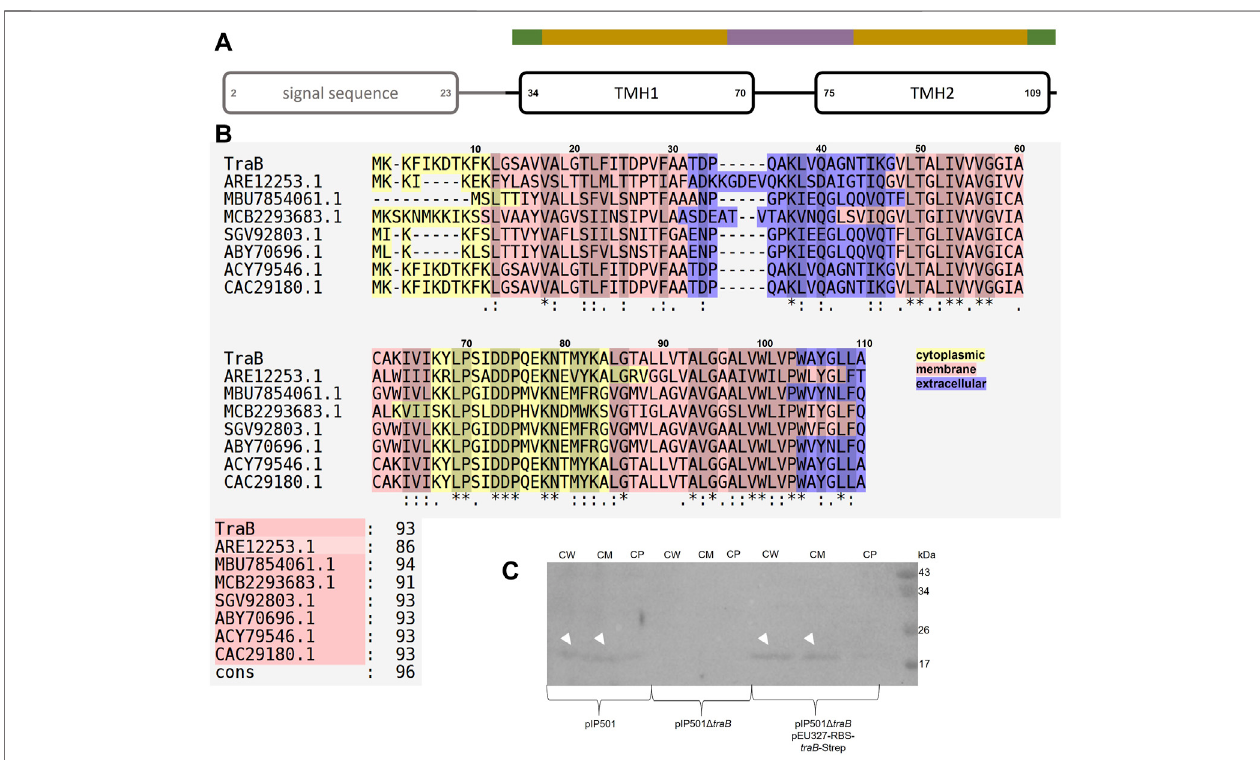
FIGURE 2 | (A) Domain composition of TraB. The fi rst predicted helix is part of the secretion signal sequence (predicted with SignalP5.0) including a cleavage site between alanine 30 and alanine 31. Secondary structure elements were calculated with PSIPRED. After a short coil structure, the fi rst transmembrane helix (TMH1) spans from proline 34 to proline 70 followed by a short loop region leading to the second transmembrane helix (TMH2) starting at proline 75 and ending at leucine 109. MEMPACK and MEMSAT-SVM were used to determine the orientation of TraB in the membrane as represented by the color code above the TMHs. Green parts are predicted to be extracellular, golden parts within the membrane and the lavender part intracellular. (B) Multiple sequence alignments using PSI/TM-Coffee for membraneproteinsfromtheT-coffeeserverofTraBanditsorthologsfromotherputativeconjugativesystems.Orthologswereidenti fi edbyaniterativePSI-BLASTusing the NCBI databank. Only proteins originating from a conjugative context were included in the multiple sequence alignments. The color scheme shows the orientation of the proteins mapped on to their sequence. The panel to the right shows the evaluation scores from the TCS evaluation. Asterisks “ * ” show conserved amino acids in all sequences.Colons “ : ” indicate aminoacidsofhighsimilarities.Dots “ . ” indicate partialsimilarities.Inaddition, identicaland highly similar aminoacidsarehighlightedwith grey shading of therespective alignment boxes. The numbers above the aligned sequences are referring tothe amino acidposition ofTraB pIP501 (C) WesternBlot ofthe